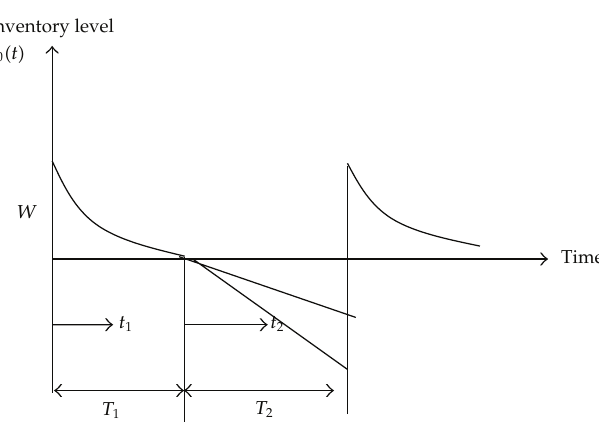
Figure 4: Graphical representation of the OW inventory system (cid:2) one warehouse-own (cid:3)